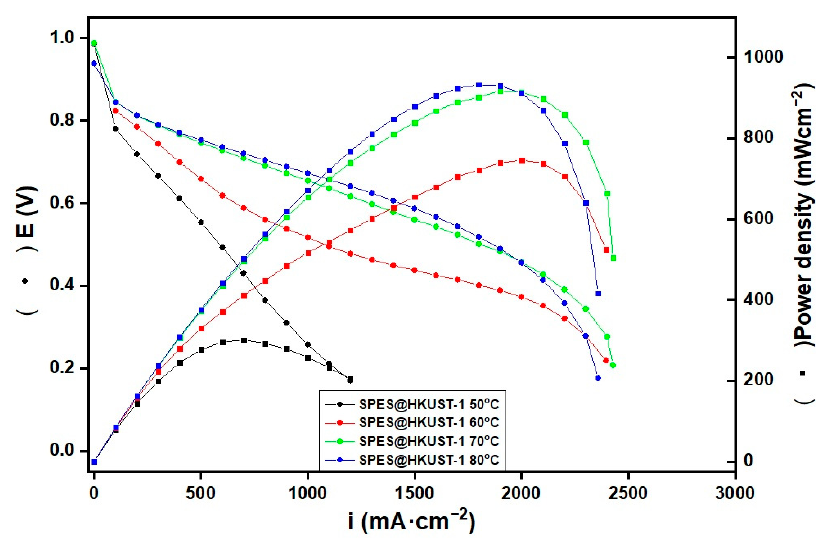
Figure 9. Polarization and (B) power density curves of the SPES@HKUST-1 membrane at 50, 60, 70, and 80 °C and 100% RH.